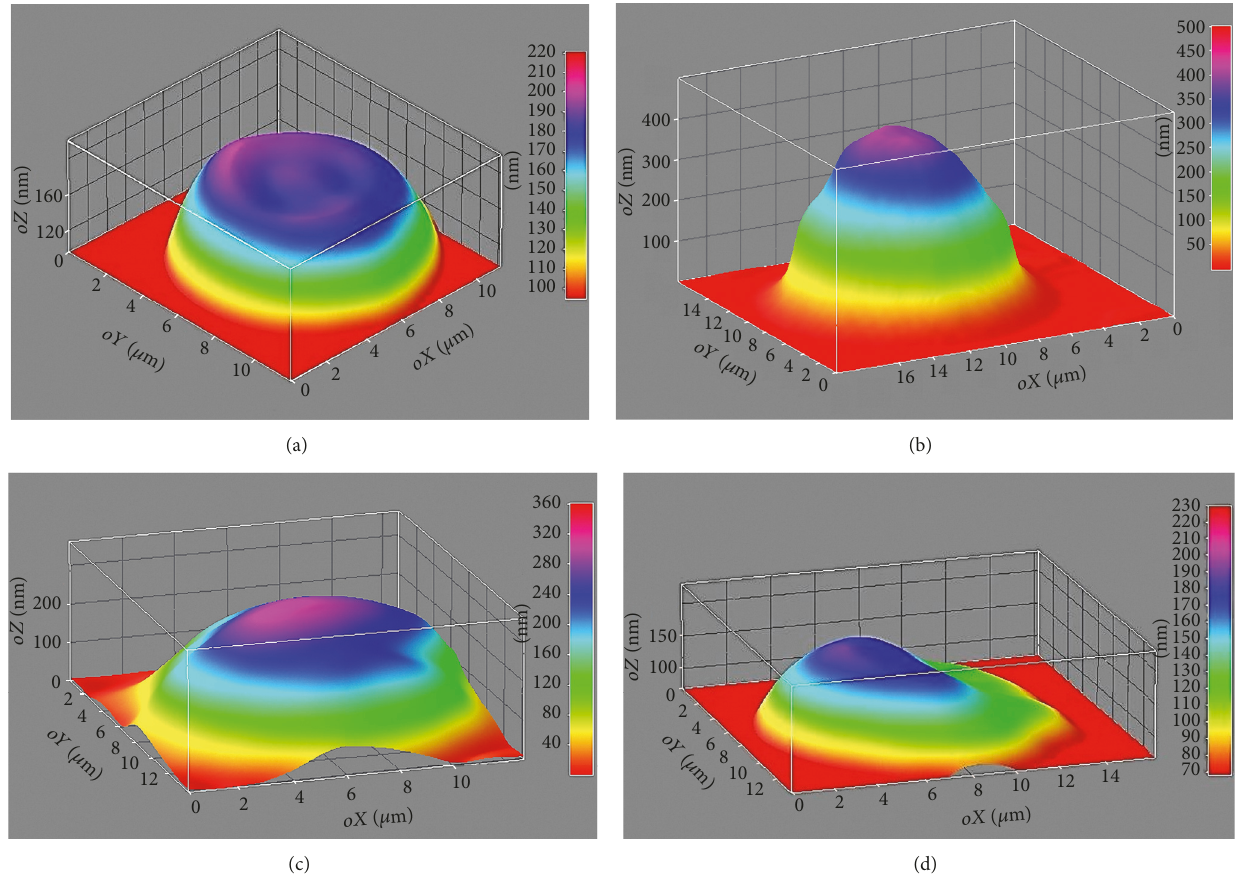
Figure 1: Phase images of erythrocytes, taken using LIM ( 𝑜𝑋 , 𝑜𝑌 : erythrocyte sizes, 𝜇 m; 𝑜𝑍 : optical path difference (OPD), nm): (a) erythrocyte from a healthy donor (discocyte); (b) erythrocyte from a MI patient before treatment (spherocyte); (c) erythrocyte from a SA patient before treatment (stomatocyte); (d) erythrocyte from a MI patient after treatment (stomatocyte).